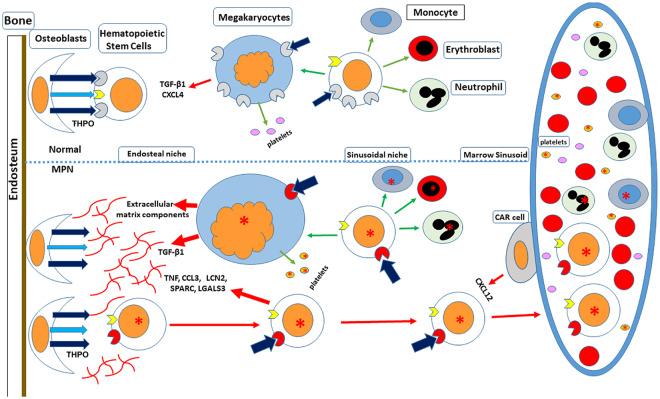
A schematic representation of the effect of impaired MPL expression on the behavior of bone marrow HSC.In the endosteal niche, HSCs are tethered to osteoblasts by a variety of adhesive proteins () and their receptors (), and thrombopoietin () and its receptor, MPL, (), and are maintained in a quiescent state by platelet factor 4 (CXCL4) and TGF-β, secreted by closely opposed megakaryocytes. In the MPN, reduced cell surface expression of MPL () facilitates egress of hematopoietic stem cells expressing a driver mutation () from the endosteal niche followed by migration to the sinusoidal niche, expedited by the stromal cell-derived growth factor-1 (CXCL12), secreted by CXCL12-abundant reticular (CAR) cells; there the stem cells can either differentiate () in response to THPO, the plasma level of which is high in the MPN due to reduced platelet MPL cell surface expression, or leave the marrow () via the sinusoids for residence in the spleen or other organs. MPN HSCs, like chronic myeloid leukemia HSC, also produce inflammatory cytokines, including tumor necrosis factor (TNF), macrophage inflammatory protein 1α (CCL3), osteonectin (SPARC) and Lipocalin 2 (LCN2), which alter the marrow cellular microenvironment, suppressing normal hematopoietic stem cells and promoting myelofibrosis ().